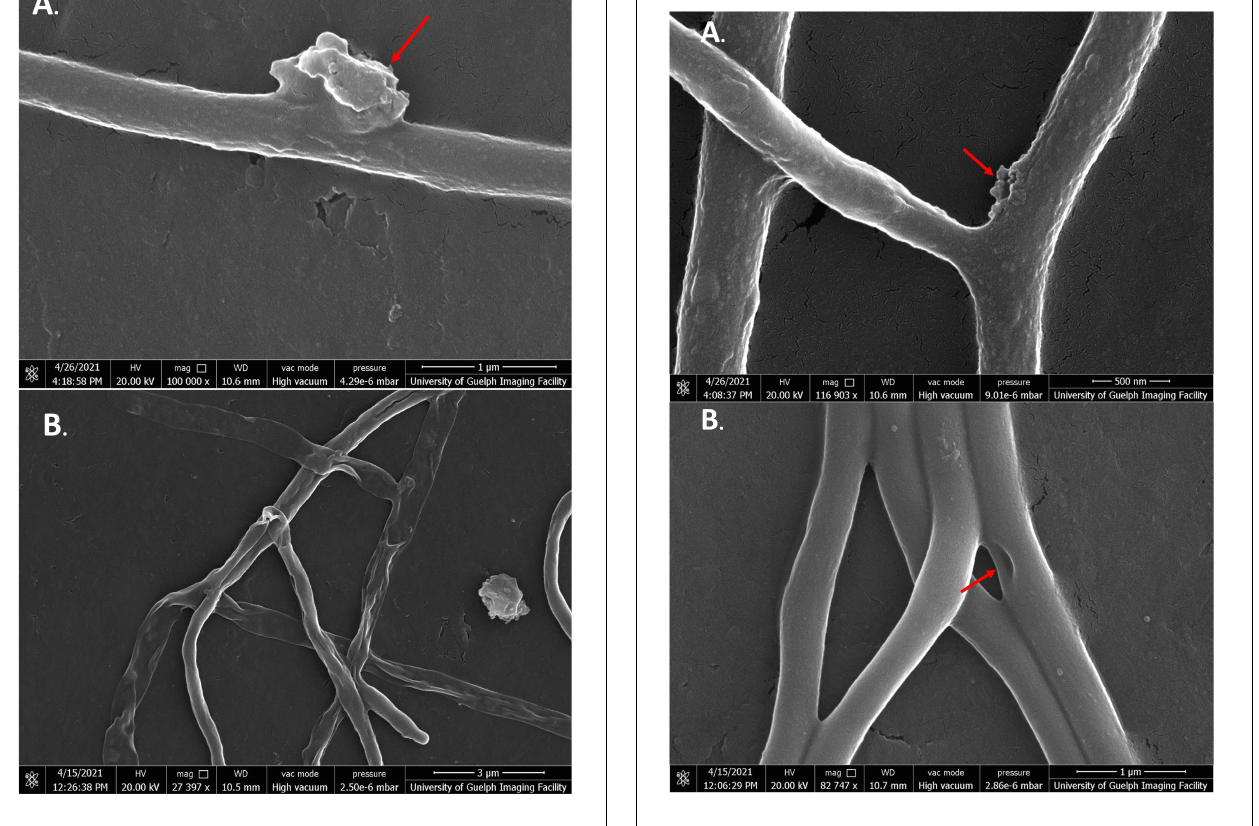
FIGURE 7 | SEM images of S. scabies in the presence of baicalein. (A) S. scabies grown overnight in nutrient broth with 4% DMSO and baicalein at MIC concentration as well as a metal spring for shearing and shown at 100,000 times magnification. The red arrow points to an abnormal growth that can be seen on the outside of cells. (B) S. scabies in the presence of baicalein at MIC concentration shown at 27,397 times magnification. Images were taken via a Quanta 250 FEG SEM (FEI company, OR, United States).